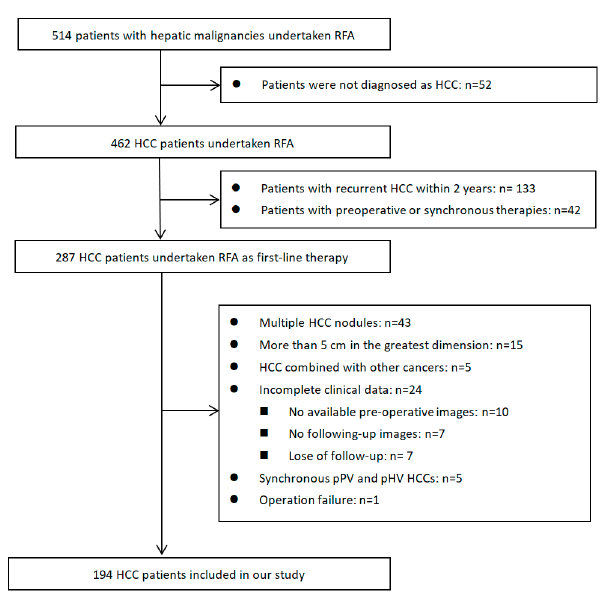
Figure 1. Flow diagram of patients identified, included, and excluded. RAF: Radiofrequency ablation; HCC: Hepatocellular carcinoma.